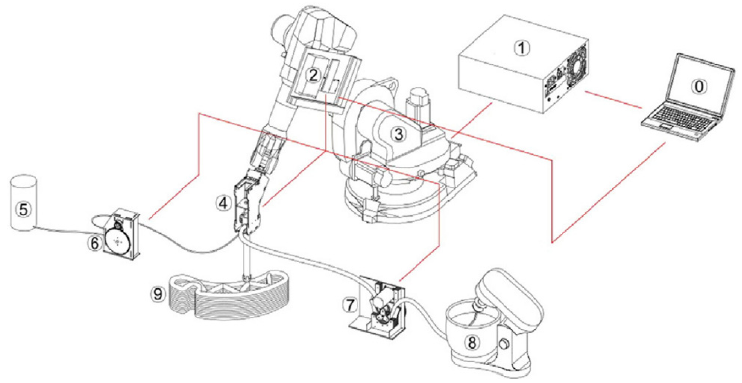
Figure 1. Illustration of 3D concrete printing system [20].